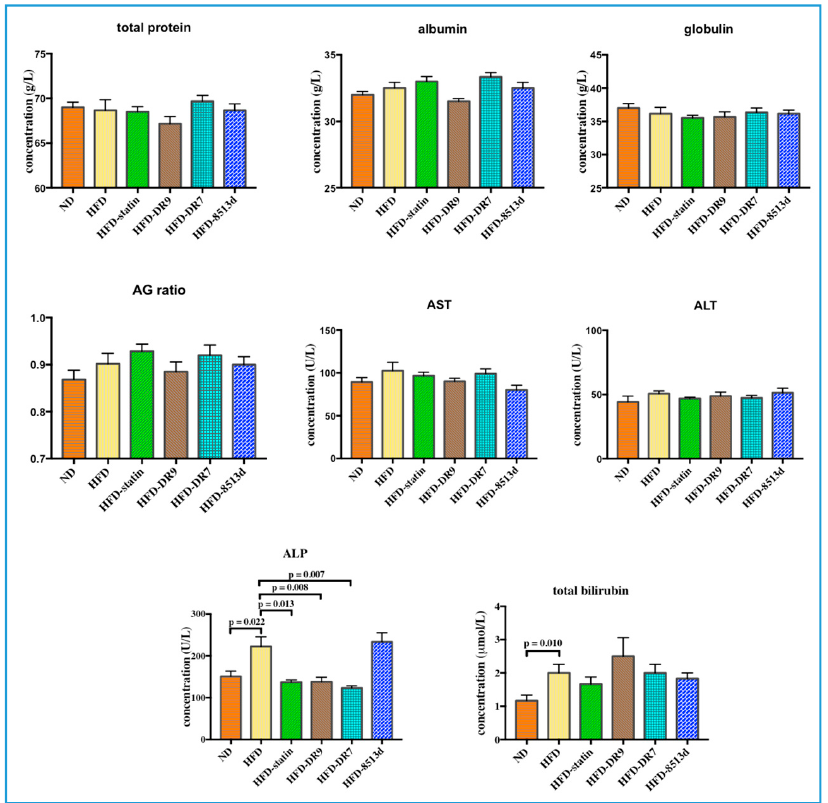
Figure 4. Liver function test, including total protein, albumin, globulin, AG ratio (Albumin / Globulin ratio), AST (aspartate aminotransferase), ALT (alanine aminotransferase), ALP (alkaline phosphatase), and total bilirubin in D-galactose-induced aging rats (600 mg / kg / day) after 12 weeks of treatment. ND (normal diet), HFD (high-fat diet), HFD-statin (high-fat diet, receiving lovastatin 2 mg / kg / day), HFD-DR9 (high-fat diet, receiving L. fermentum DR9 (10 10 CFU / day), HFD-DR7 (high-fat diet, receiving L. plantarum DR7 (10 10 CFU / day), HFD-8513d (high-fat diet, receiving L. reuteri 8513d (10 10 CFU / day). Results are expressed as mean; error bars (SEM); n = 6. Statistical analysis was performed using independent t -tests.